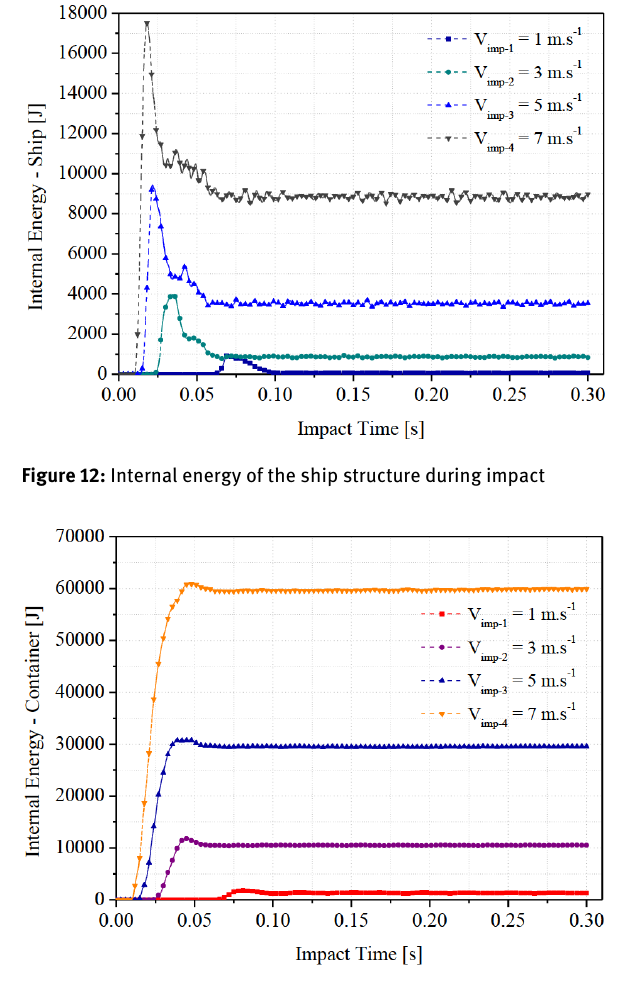
Figure 13: Tendency of the container energy shows similarity to the global energy